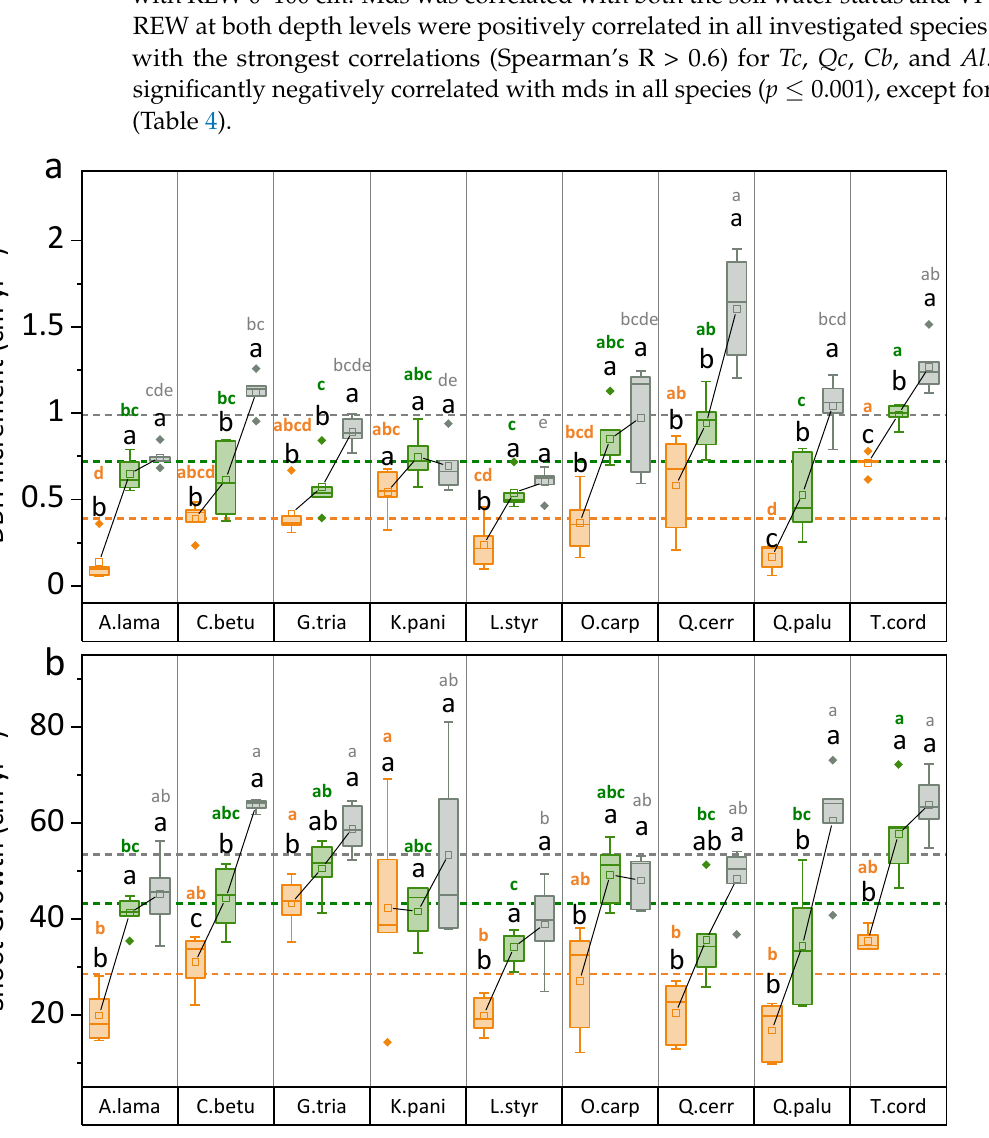
Figure 4. ( a ) Boxplots of annual DBH growth and ( b ) annual shoot growth of all nine tree species and as a mean of the years 2020–2021. Colored dashed lines show the mean growth across all species for the three planting soils ‘Sand‘ (orange), ‘FLL‘ (green), and ‘Loamy Silt‘ (grey). Statistical analyses were performed by using a one-way ANOVA. Boxes with the same letters (black) indicate no significant differences at the p ≤ 0.05 level within a species between the planting soils. Boxes with the same letters (see color assignment above) indicate no significant differences at the p ≤ 0.05 level within a planting soil between the species. Mean comparisons were performed by Tukey post hoc comparisons.